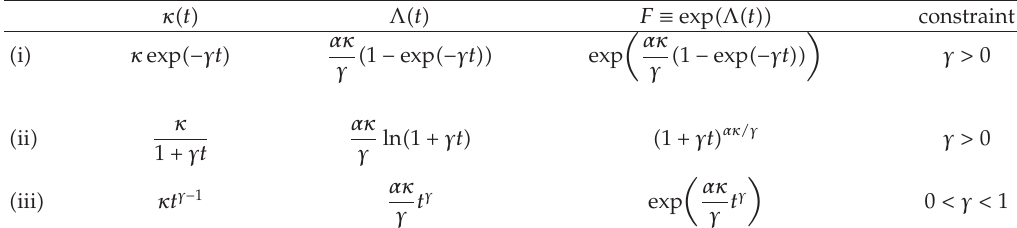
Table 2: Some examples of κ (cid:3) t (cid:4) , and corresponding Λ(cid:3) t (cid:4) and exp (cid:3)Λ(cid:3) t (cid:4)(cid:4)